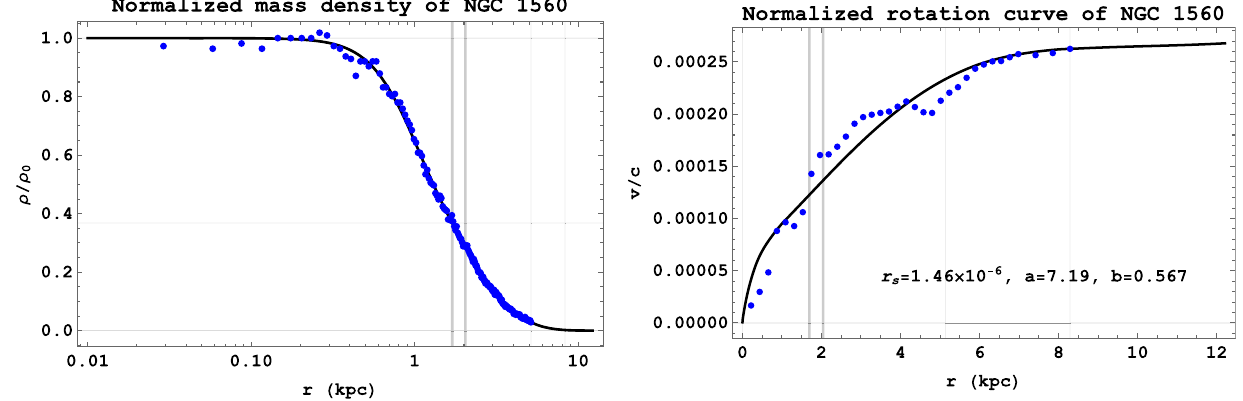
Fig. 4 The line in the left-hand side graphic shows the mass density profile fitted to the observed luminosity profile of NGC 1560, repre- sented by dots. The line in the right-hand side shows the rotation curve fittedtotheexperimentalvalueslistedbyBroeils[32].Thethickvertical